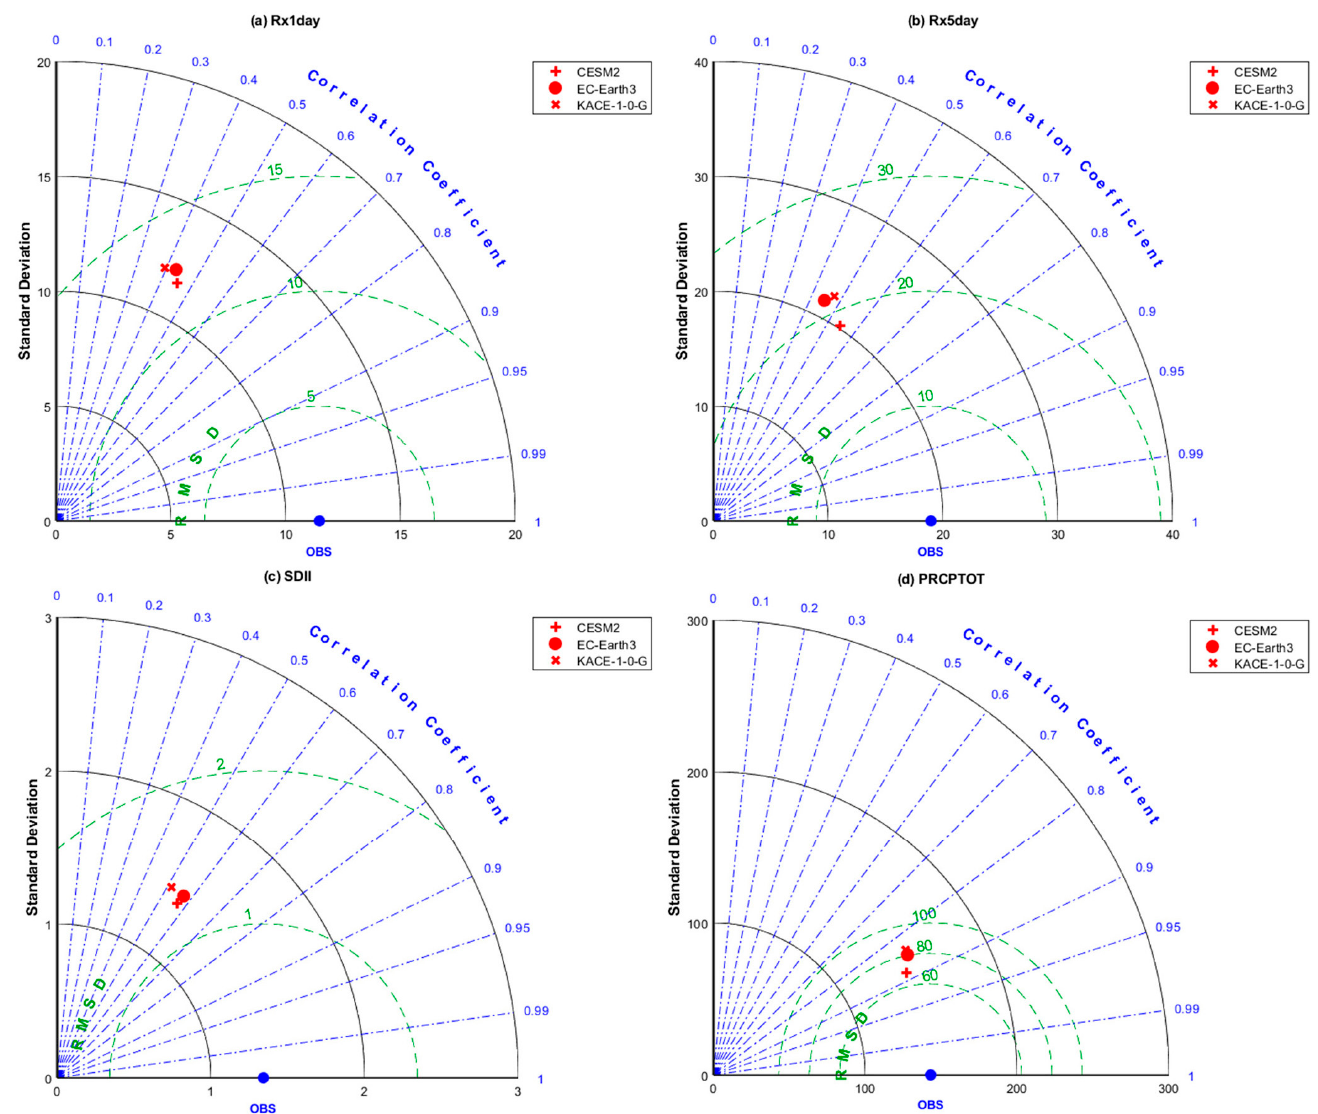
Figure 5. Taylor diagrams indicating correlation coefficients, standard deviation, and RMSE of Rx1day, Rx5day, SDII, and PRCPTOT from 1970 to 2014. Table 3. Statistical errors of the eight extreme precipitation indices between the original CMIP6 models and the observed values.